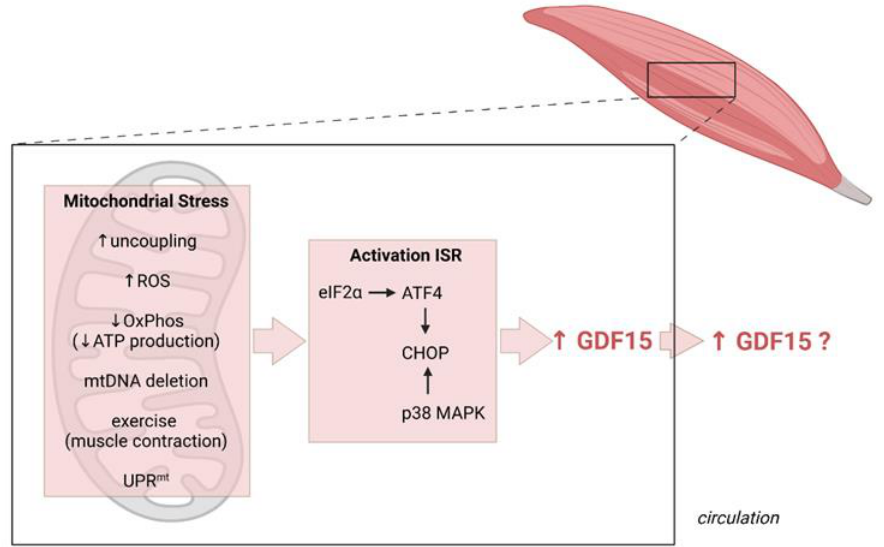
Figure 2. Induction of GDF15 as a myomitokine. Different (patho)physiological conditions resulting in increased muscle mitochondrial stress activate the integrated stress response (ISR) culminating in a CHOP-dependent induction of GDF15 expression which can, but does not necessarily, result in increased secretion and circulating GDF15 levels. Figure created with BioRender.com (28 September 2021). Table 1. Animal models implicating GDF15 as a myokine/cardiokine.